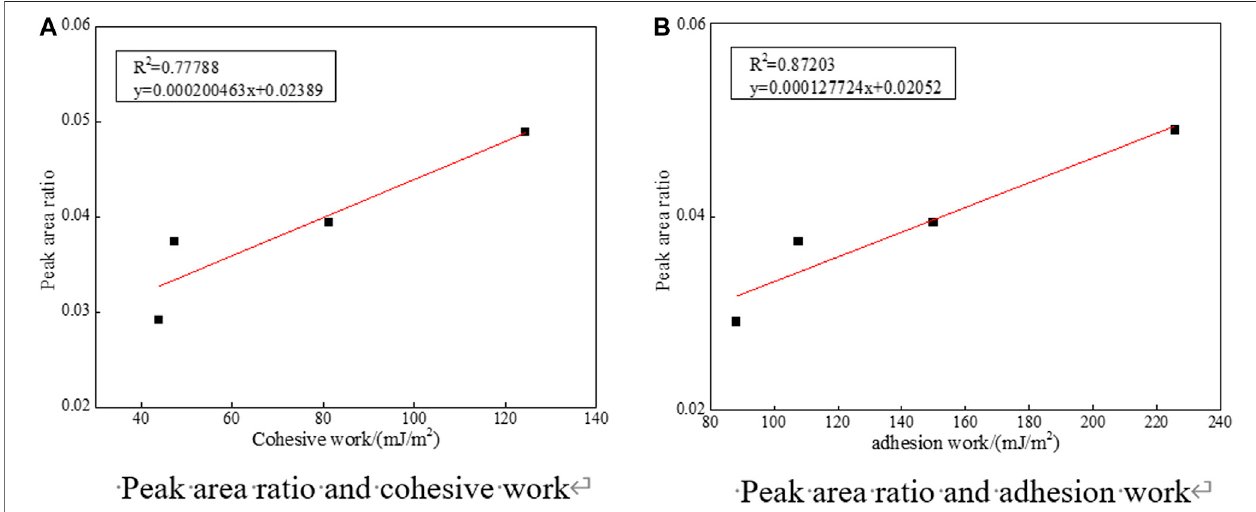
FIGURE 8 | Relation between macroscopic adhesion properties and micro-adhesion performance characterization methods. (A) Peak area ratio and cohesive work. (B) Peak area ratio and adhesion